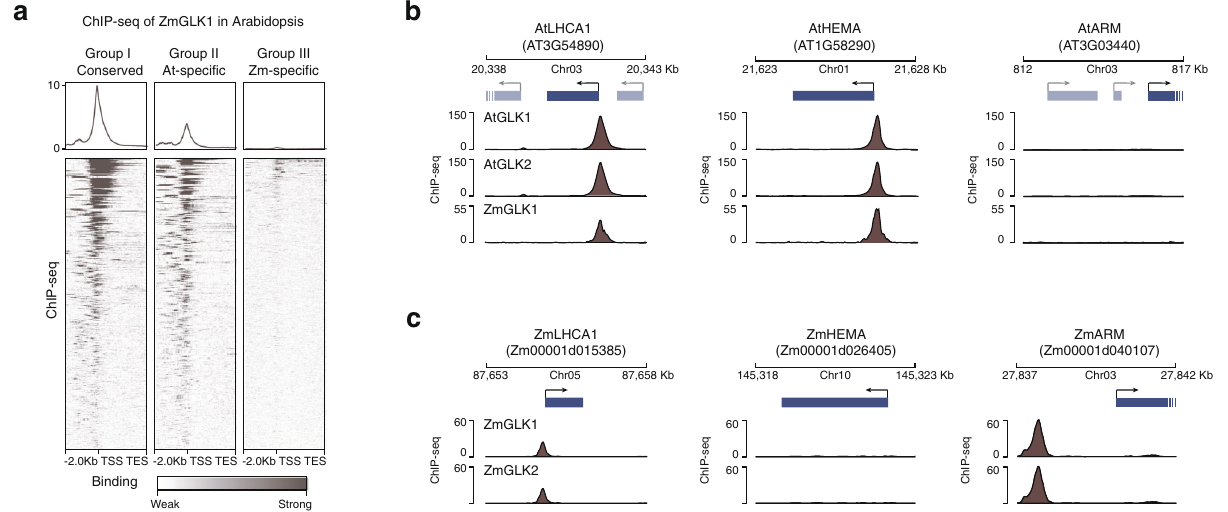
Fig. 6 | Binding of the heterologously expressed ZmGLK1 in Arabidopsis genome. a Heatmap of ZmGLK1 ChIP-seq signal in three groups of Arabidopsis genes. b Genome browser tracks showing representative genes in groups one to three. c Tracks showing the maize homologous